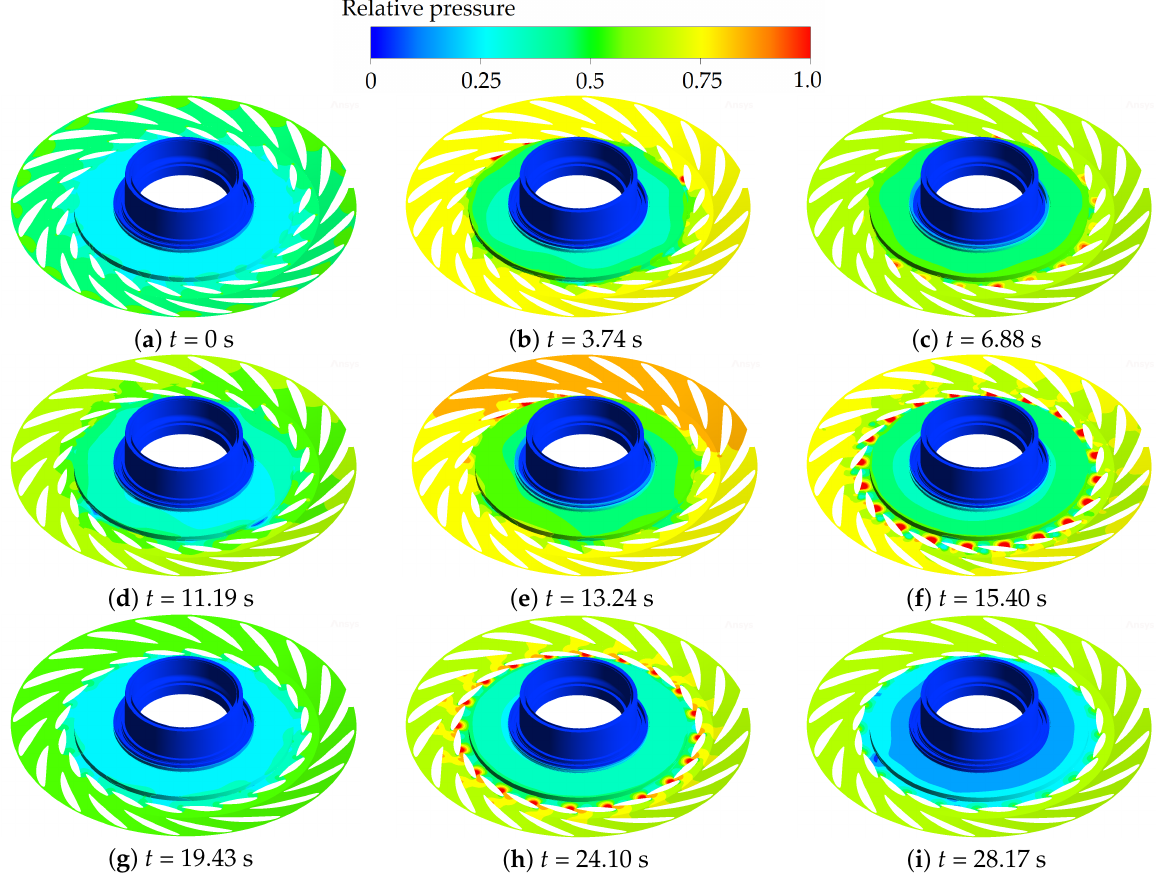
Figure 9. Pressure distribution in the flow passages at different key time